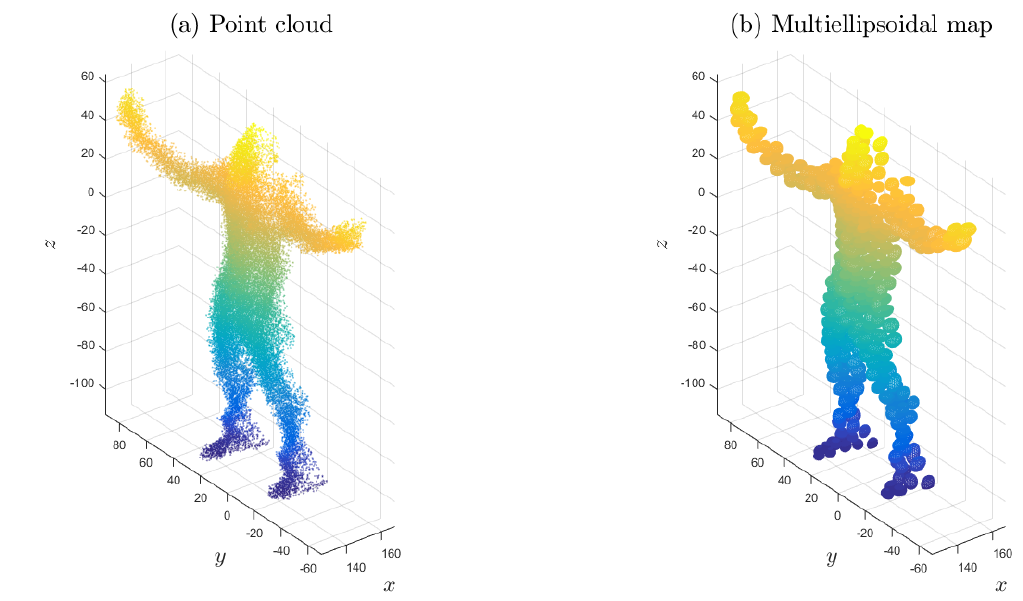
Figure 5. Experiment